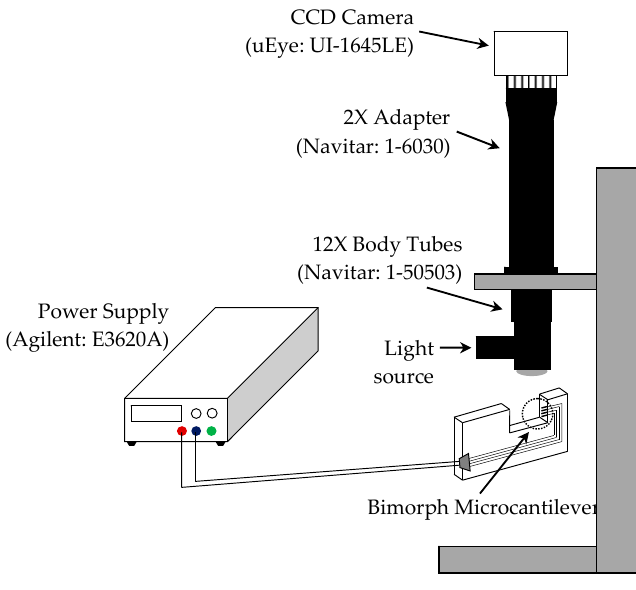
Figure 9. Schematic setup of measurement experiment.